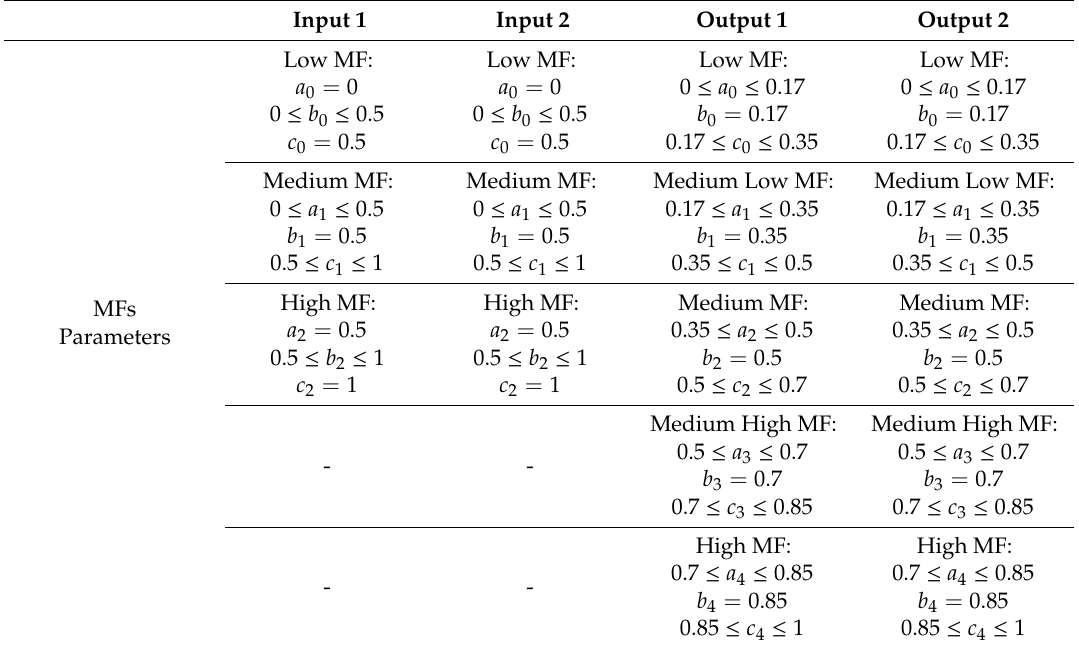
Table 3. Limits of the parameters of the membership